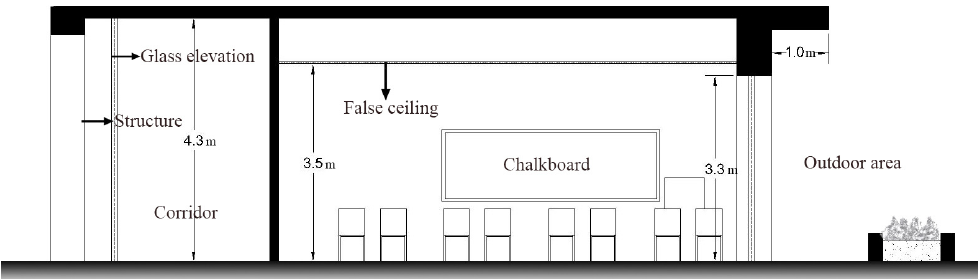
Buildings 2018 , 8 , x FOR PEER REVIEW Figure 2. Section at a typical classroom at JUST showing the class geometry and desks plane level.